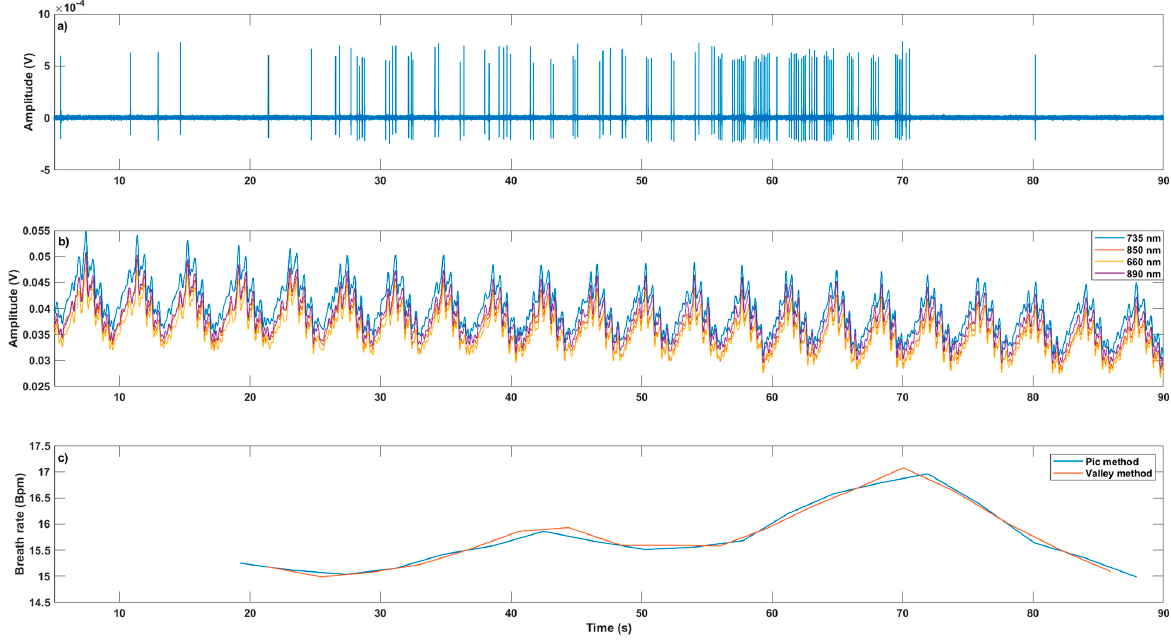
Figure 11. Temporal evolution of optical responses in transmission mode ( b ) and breath rate ( c ) at the spinal cord level with the electrostimulation ( a ) (Bpm: Breaths per minute).